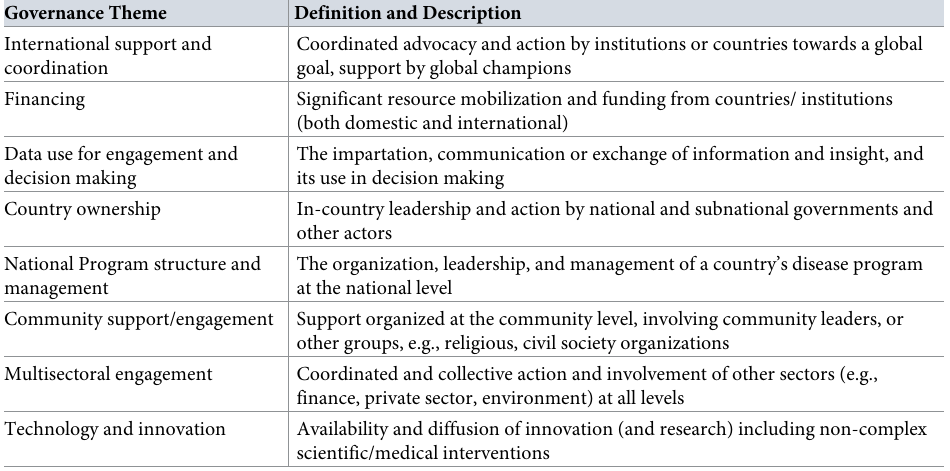
Table 1. Governance themes in disease control